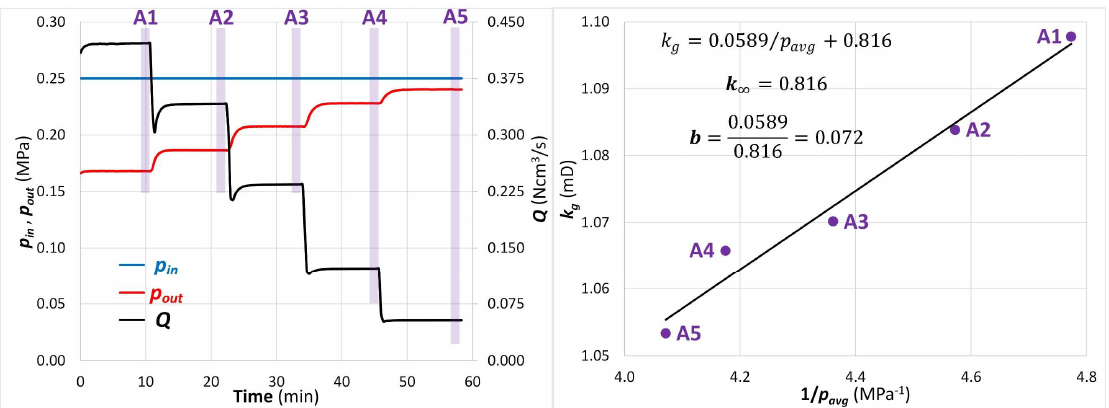
Figure 5. A sample course in the changes of the registered parameters for a single measurement procedure (with the sample porosity amounting to 18.87% and the stress value equaling 0 MPa—the graph to the left) and the permeability coefficients k g obtained on that basis as a function of the reverse average pressure of gas in the sample (the graph to the right).